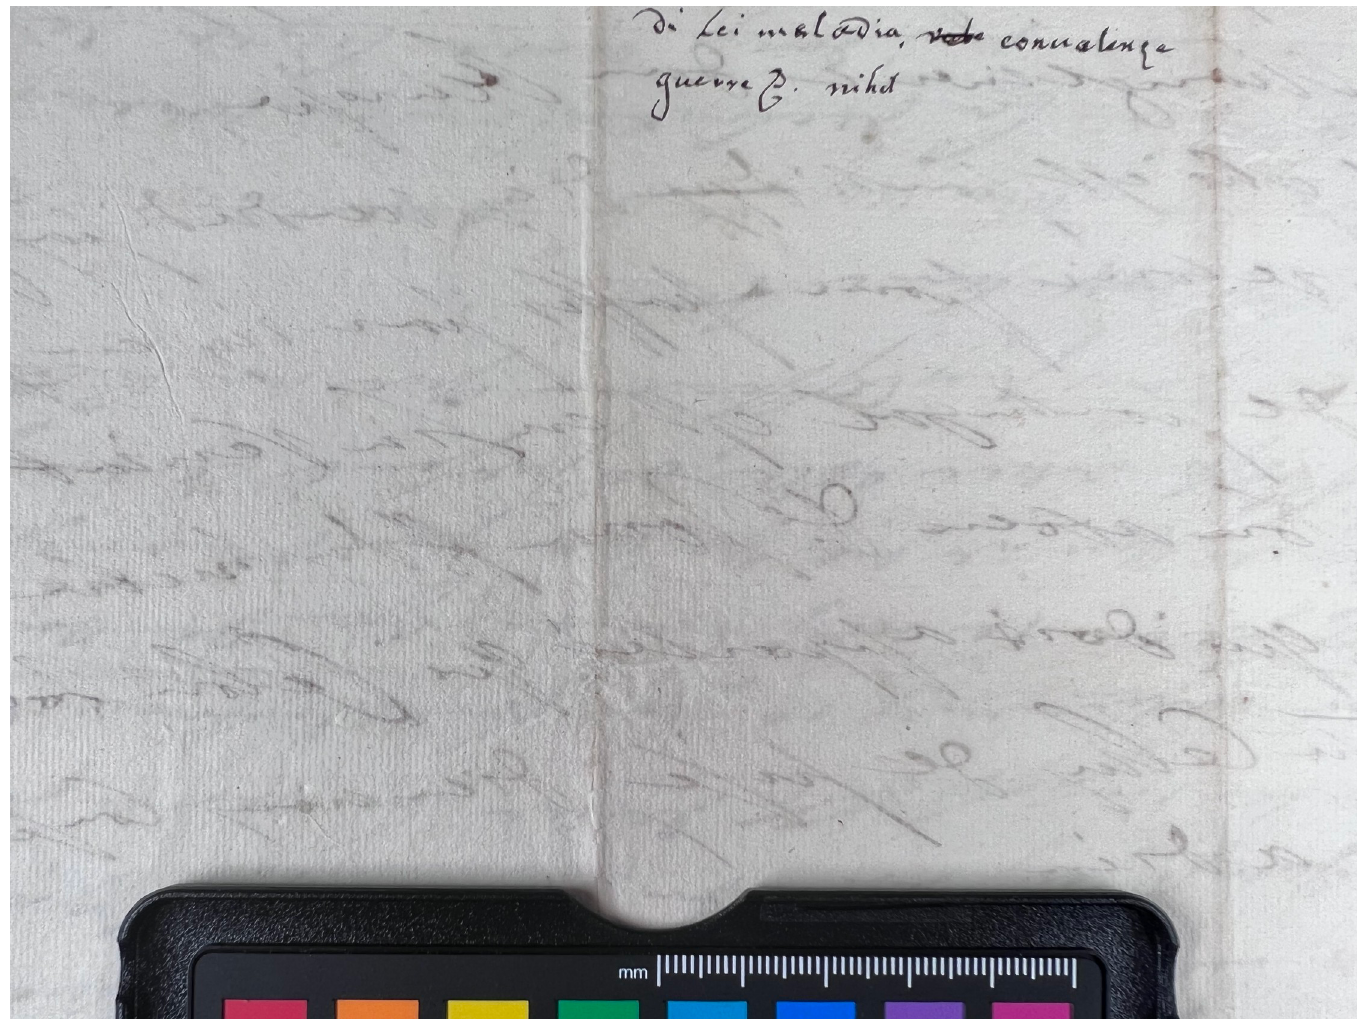
Fig 1. Burn through category 1. Example of document from the Azzolino collection displaying burn through 1 from verso.